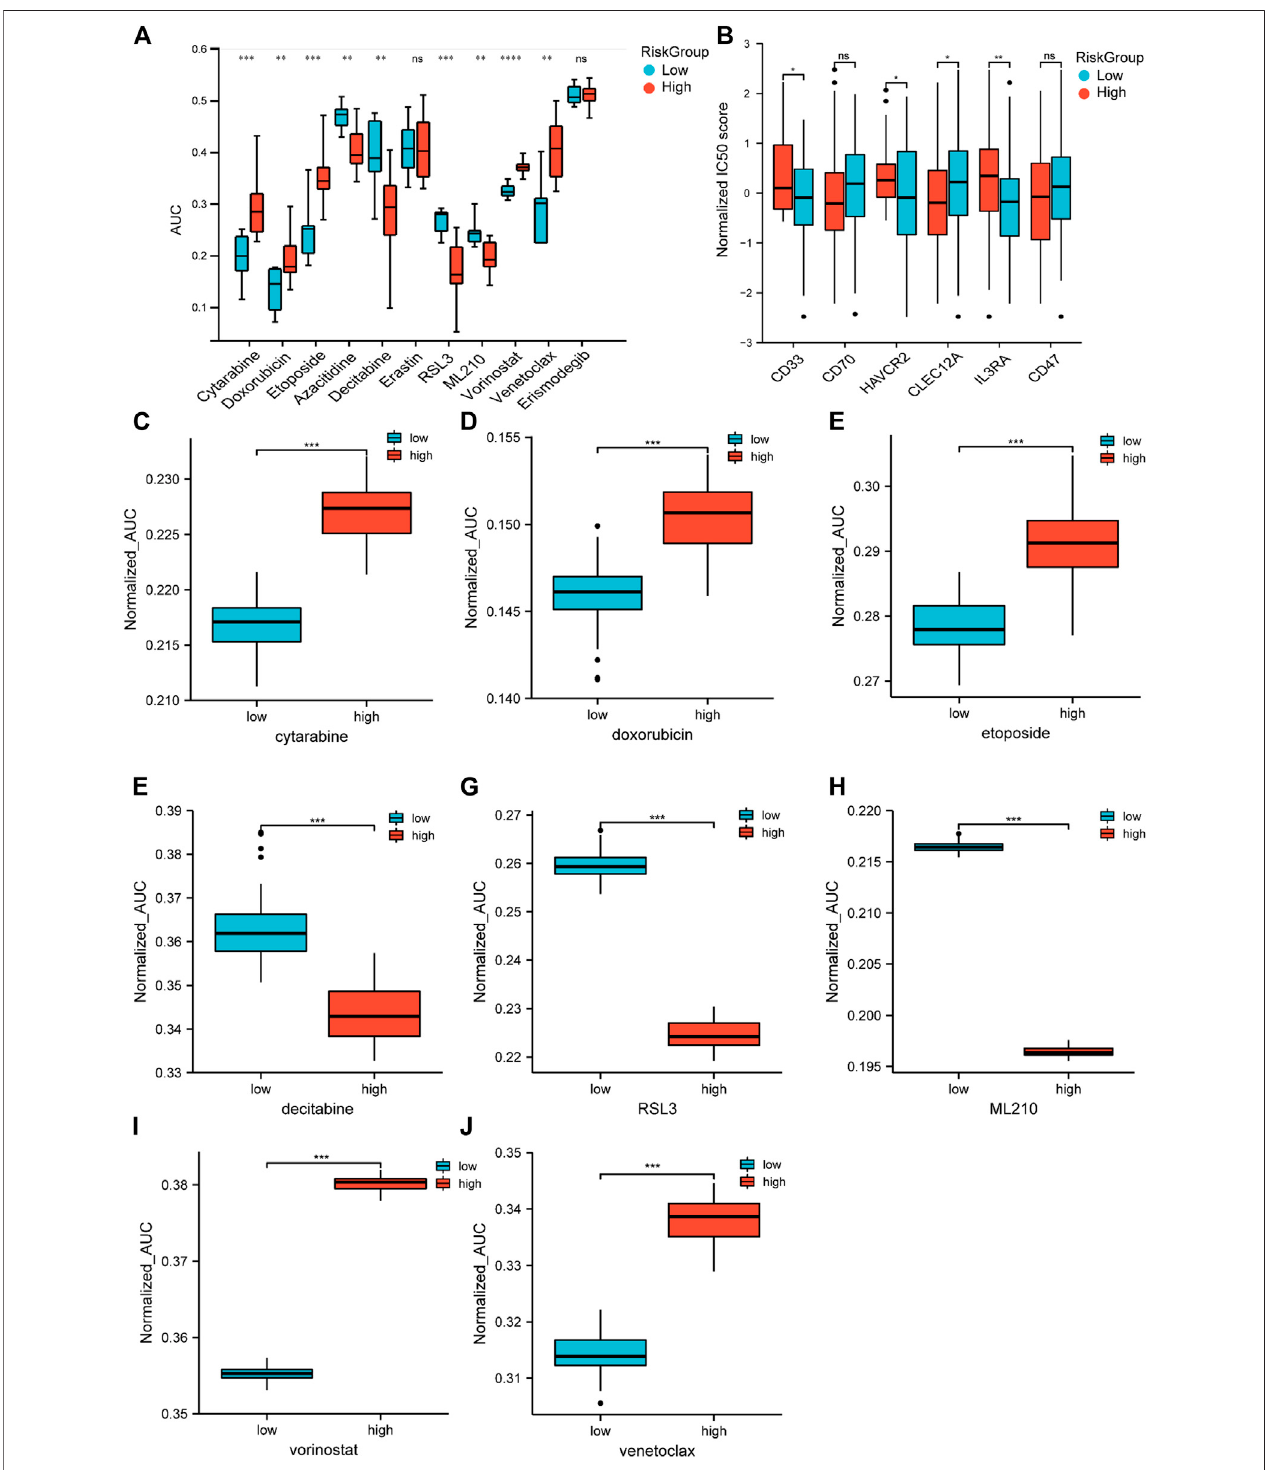
FIGURE 8 | Drug response prediction in cell lines and samples. (A) Cell-based drug response of different risk groups. Risk scores were calculated by 13-gene expressioninCTRP ’ sAMLcelllines.Then,thescoredividedthemintotworiskgroupsbasedontheuniversalcut-off.LowerAUCvaluemeansbetterdrugresponse. (B) CD33, CD70, HAVCR2, CLEC12A, IL3RA, and CD47 expression in different risk groups (Student ’ s t-tests). (C – J) Estimated drug response in different risk groups (Wilcoxon tests). Panel 8A data came from cell lines. Panel 8B – J data were obtained from TCGA datasets.